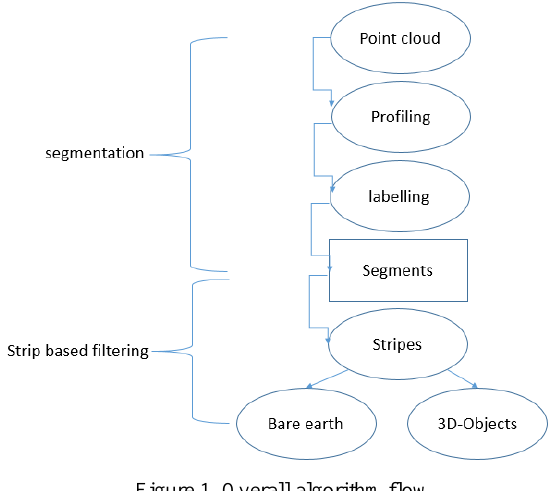
Figure 1. Overall algorithm flow